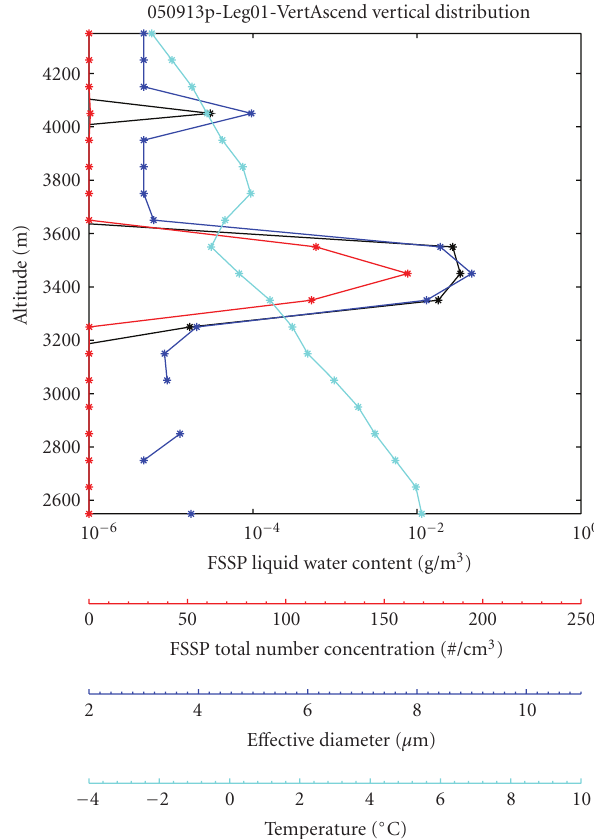
Figure 4: Measured vertical distribution of microphysical property of the cloud before the spreading. The result suggests that the cloud layer is centered at 3.4 km, and thickness of cloud layer is about 200– 300 meters. The cloud water content is about 0.04 g/cm 3 and the number of cloud particles ranges from 120 to 160 #/cm 3 with mean e ff ective diameter of 8.5–9.5 μ